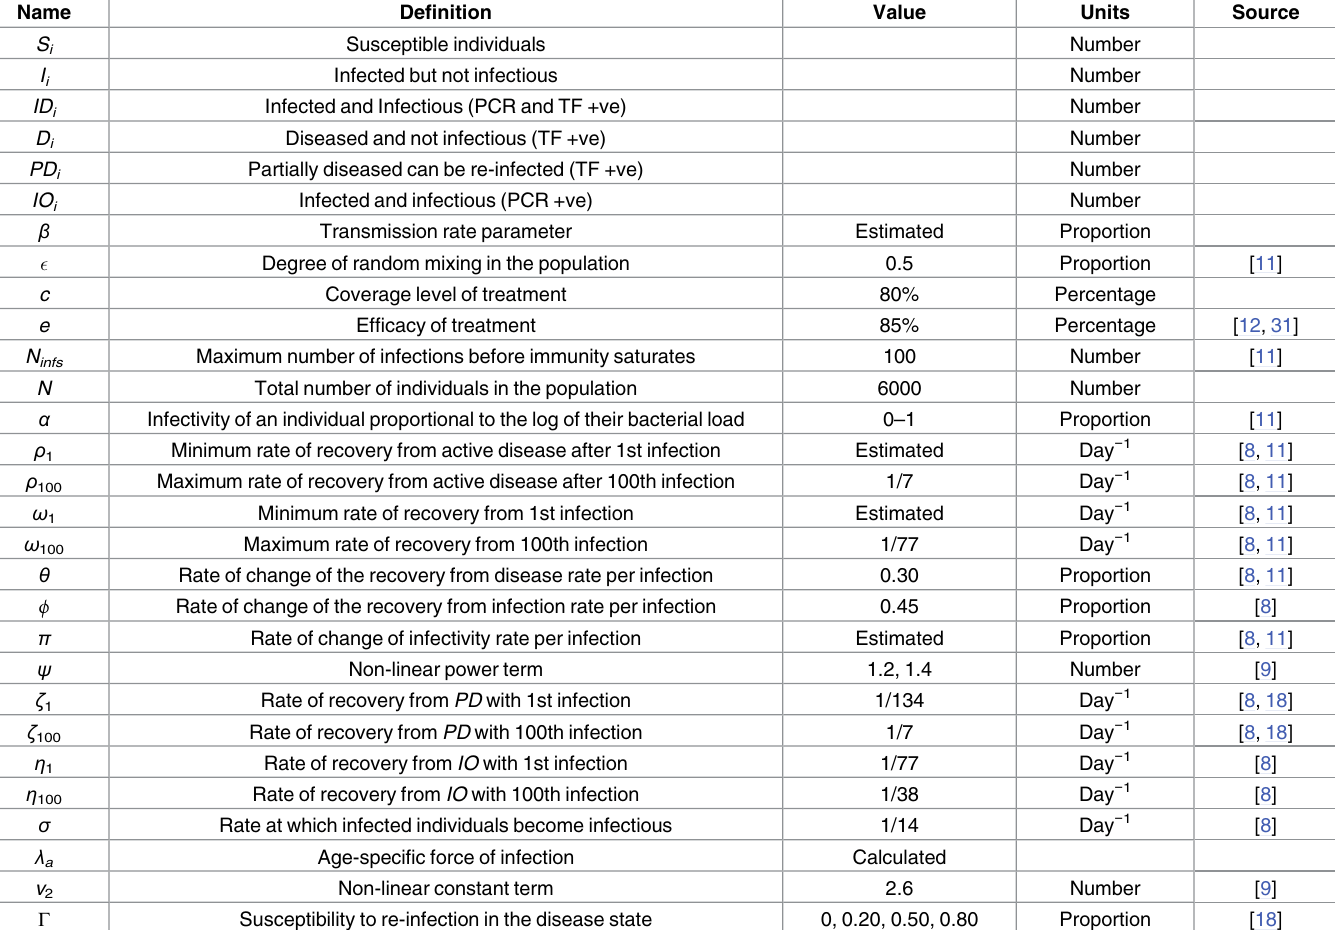
Table 1. State variables, parameters definitions and values used in the model. Where two numbers are listed for ψ , they indicate the values used for TF 40% and 20% communities.